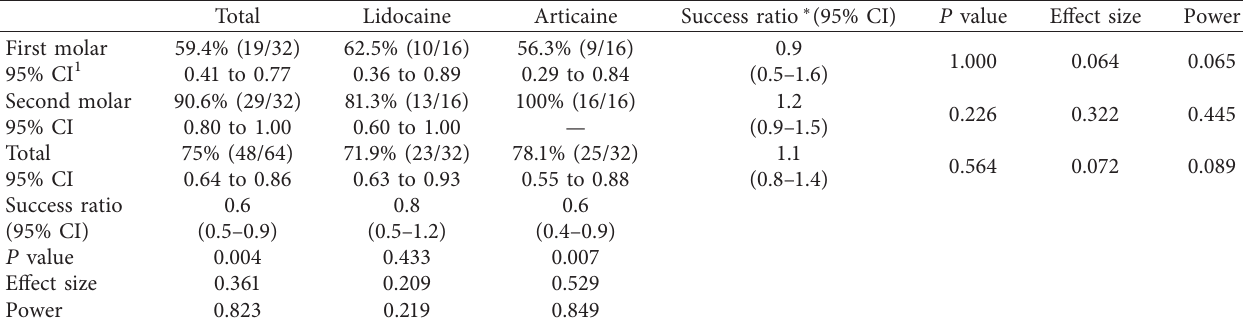
Table 1: Success rates and confidence intervals of supplemental intraligamentary injections with lidocaine and articaine in the mandibular first and second